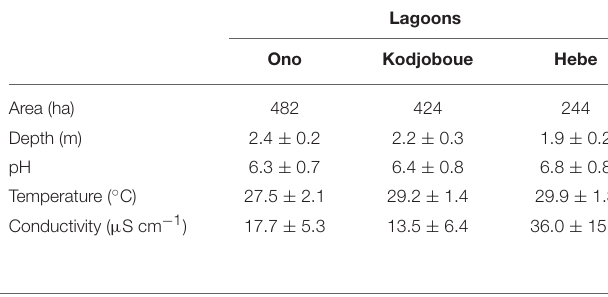
TABLE 2 | Physicochemical characteristics (average ± SD) of the three lagoons.